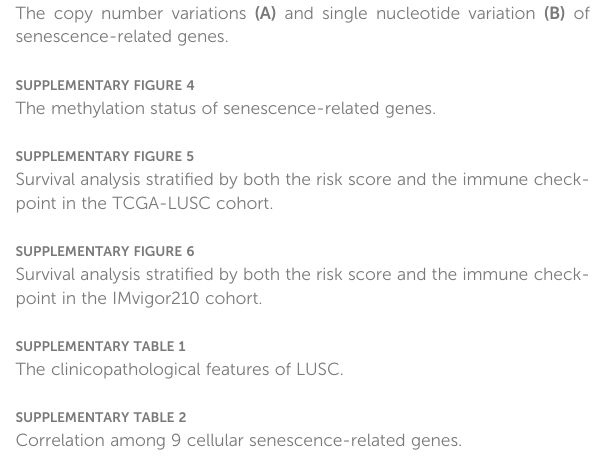
SUPPLEMENTARY FIGURE 2 Correlation analysis between senescence-related genes and immune cell